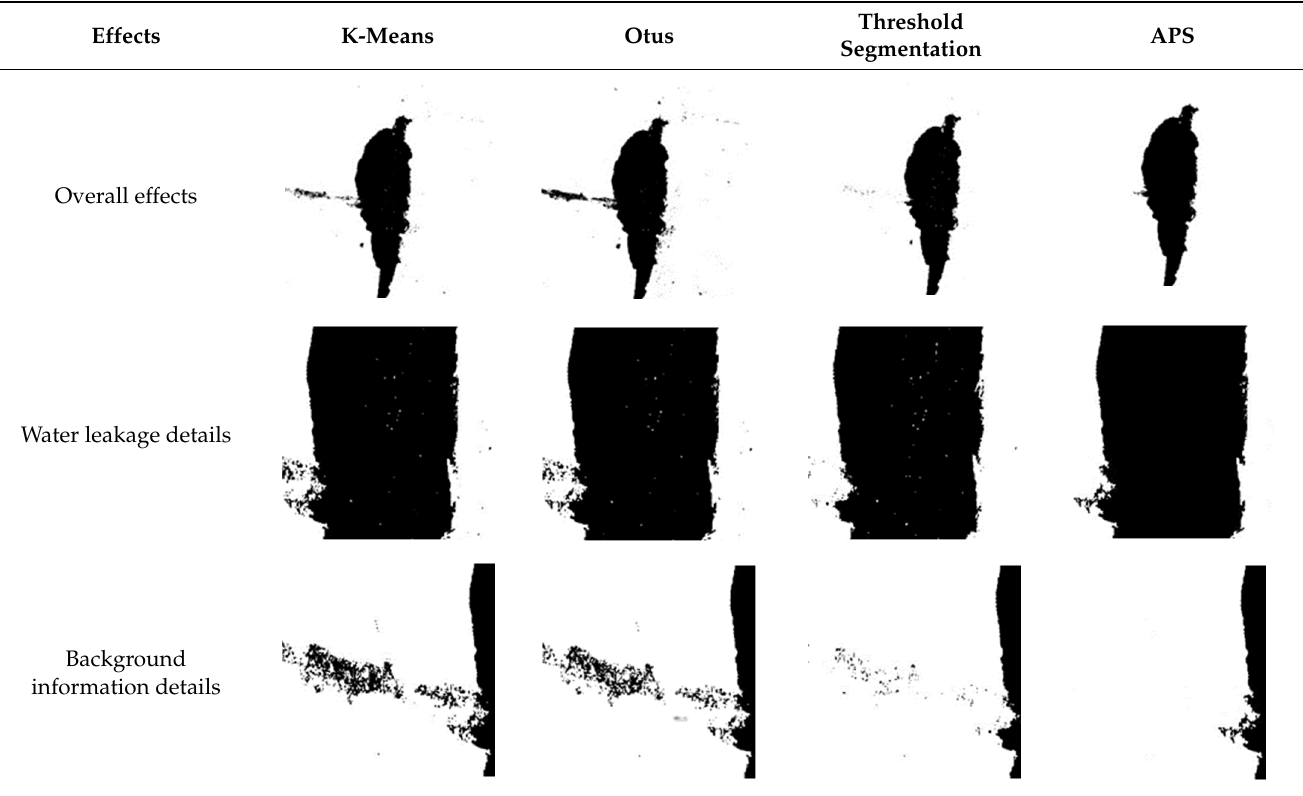
Table 4. Comparison of image segmentation algorithms.